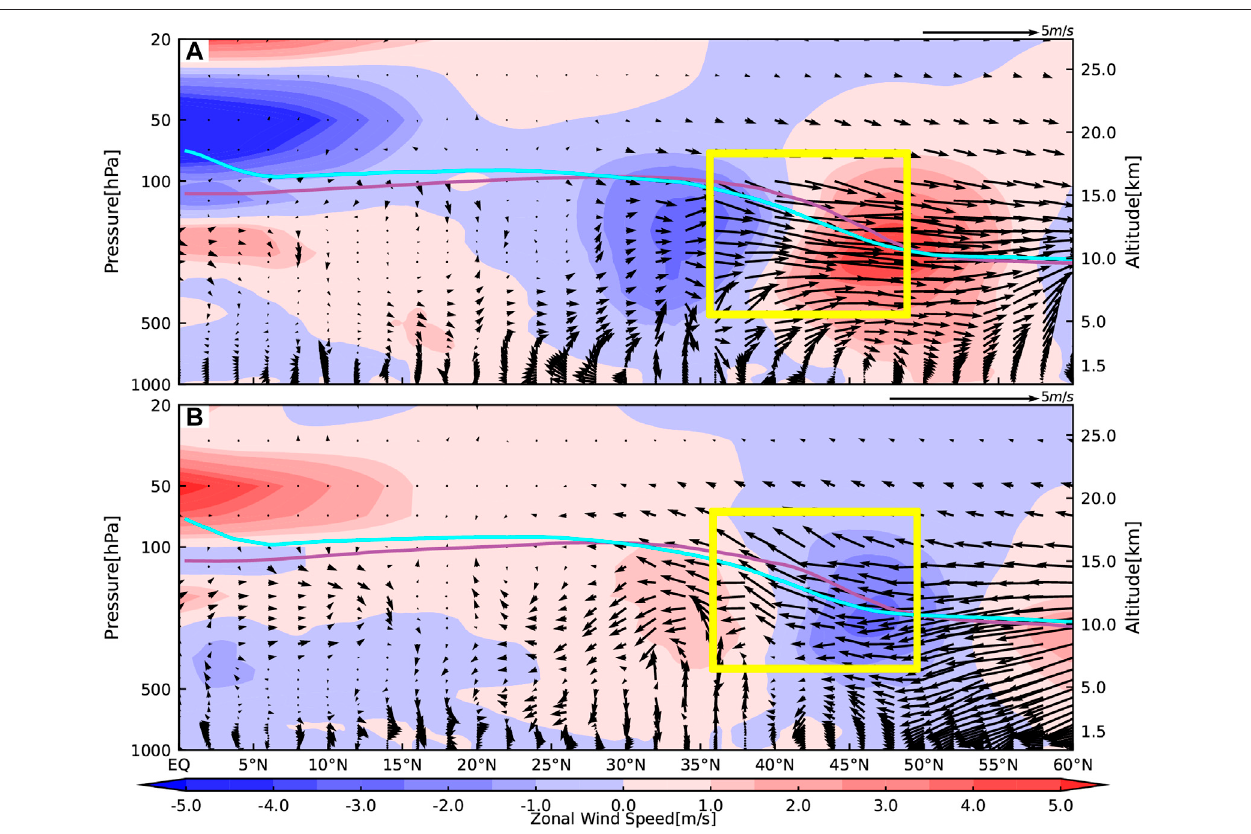
FIGURE12| Theheight – latitudecross-sectionsofthecompositewind fi eld(arrows,unit:m/s)along50 ° EfortheEOFtimeseries2inthe (A) strongeryearsand (B) weaker years. The vertical wind speed anomaly is fi ve times of the original wind fi eld. The shadows denote the zonal wind. The purple lines are the heights of the thermal tropopause and the blue lines are the heights of the dynamical